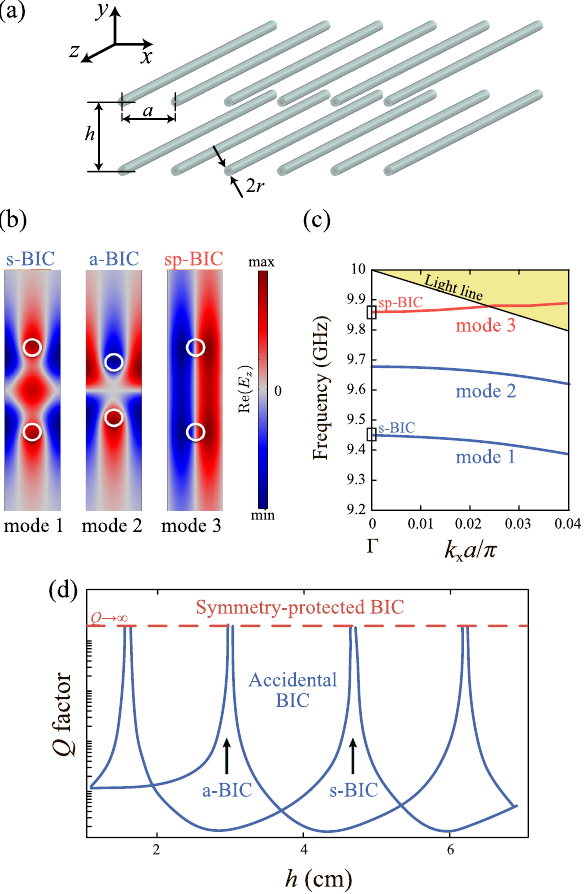
Figure 1: Bound states in the continuum in two-layered structure of infinite dielectric rods. (a) Schematic view of the photonic structure. distribution of accidental (mode 1, mode 2) and (b) Electric field E z symmetry-protected (mode 3) BICs in the Γ -point. The mode profiles are plotted for different distances between layers h ( h = 4 . 7 cm for modes 1 and 3; h = 3 cm for mode 2). (c) The band diagram of TE-polarized modes. (d) Q factor versus distance between layers h